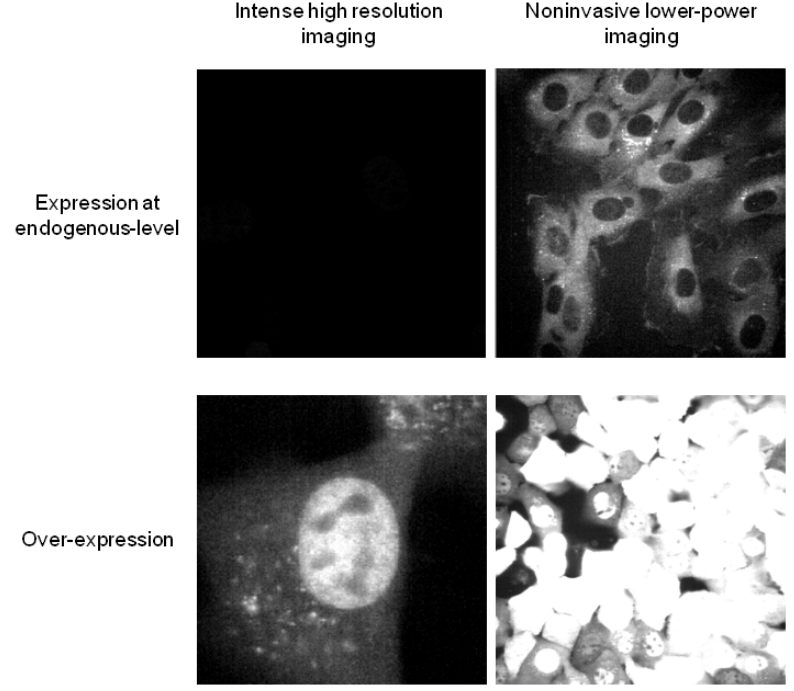
Figure 1. Lower expression requires a different set of imaging parameters. Upper panels show microscopy images of cells expressing GFP from an endogenous gene locus. Lower panels convey cells expressing a large amount of GFP under Tet-off self-amplification. Left panels are images obtained using an acquisition setting for high spatial resolution subcellular imaging, often used in cell biology. Right panel images were obtained using a setting with minimal illumination (lower power laser, shorter exposure, etc .) and maximal signal integration (zoom-out, thicker optical slice, etc .). All images were taken from Zeiss LSM 5